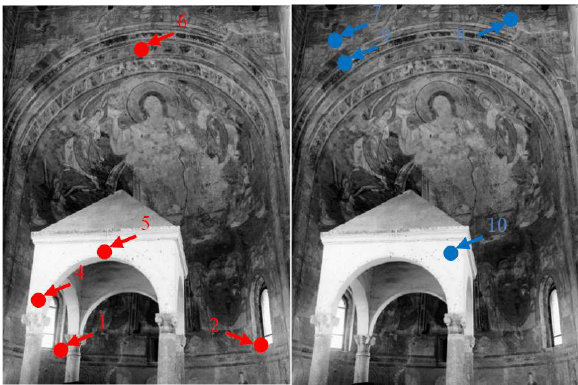
Figure 5. GCPs (left) and CPs (right) used for exterior orientation parameter and accuracy estimations (showed on the 6172 ISCR’s image)